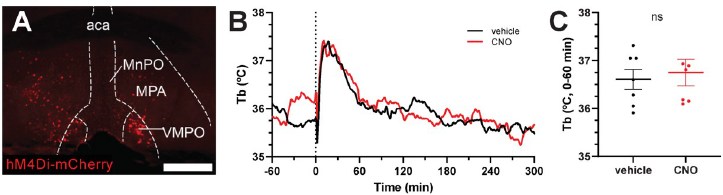
Fig 6. Chemogenetic inhibition of POA Adora1 neurons has no effect on Tb. (A) Example of hM4Di-mCherry expression in Adora1-Cre mouse injected with AAV8-hSyn-DIO-hM4Di-mCherry in the POA. Scale bar is 500 μ m. (B) Tb response to CNO (1 mg/kg, i.p.) vs. vehicle in Adora1-Cre mice with hM4Di-mCherry in POA (n = 7). (C) Mean Tb at 0 to 60 minutes after dosing. Data are mean ± SEM (SEM is omitted for visual clarity in B). P value was calculated by paired t -test comparing drug vs vehicle within mouse. Aca, anterior commissure; MnPO, median preoptic area; MPA, medial preoptic area; VMPO, ventromedial preoptic area.